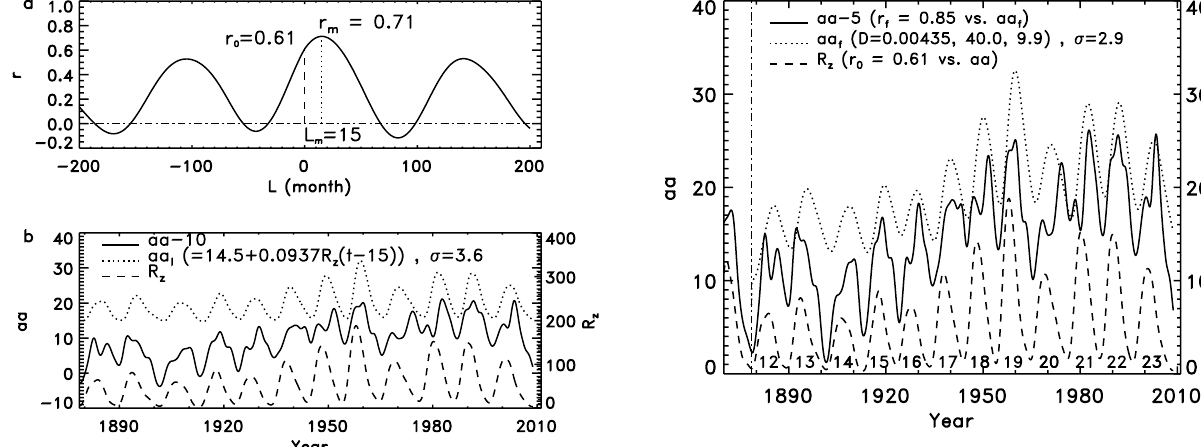
Fig. 2. (a) Correlation function between R z and aa of the lag L = − 200 , − 199, ... , 200 (months). (b) aa − 10 (solid), R z (dashed), and the reconstructed series aa l (dotted) from a linear fit of aa to the R z fifteen months earlier (9).